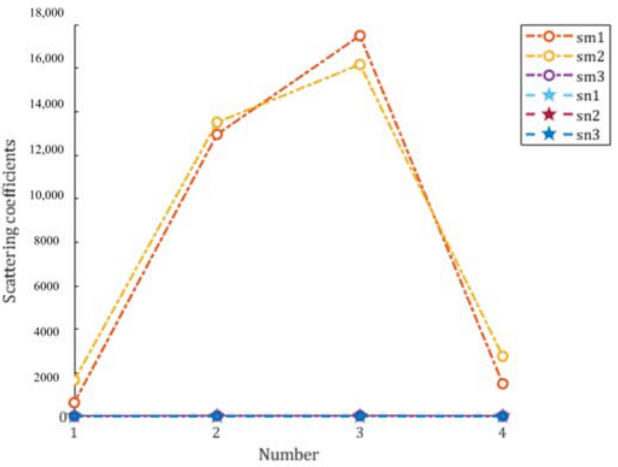
Figure 5. The distinctive scattering coefficients of microseismic events and noise .